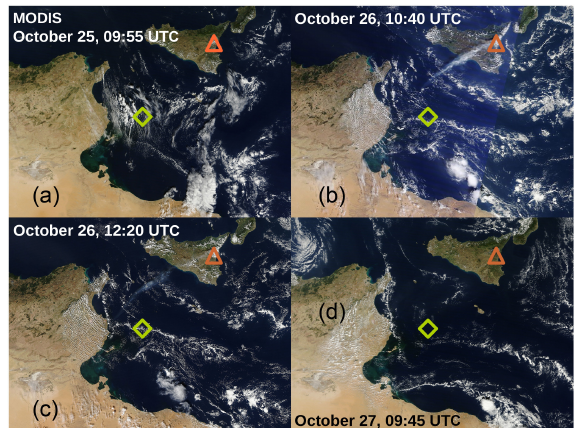
Figure 2. (a – d) MODIS true colour images showing the Mount Etna plume evolution during the period 25–27 October 2013. The position of Mount Etna is indicated with an orange triangle. The position of Lampedusa is indicated with a light green diamond.